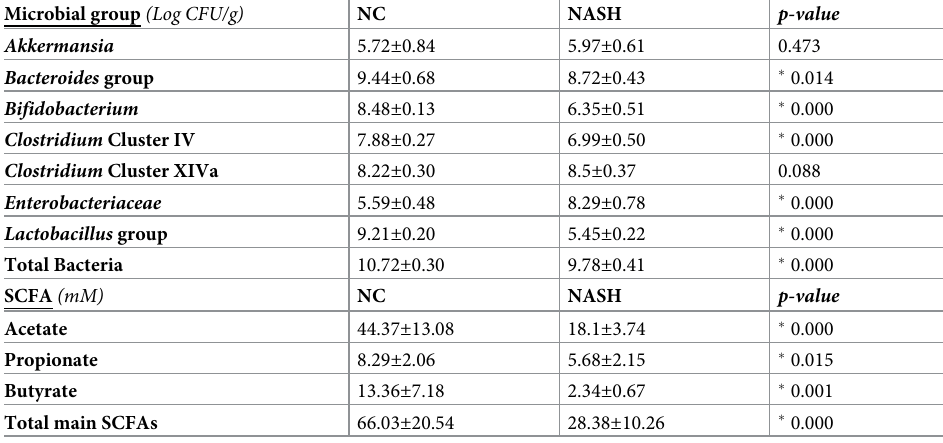
Table 3. Concentration of intestinal microbial groups and levels of SCFAs.